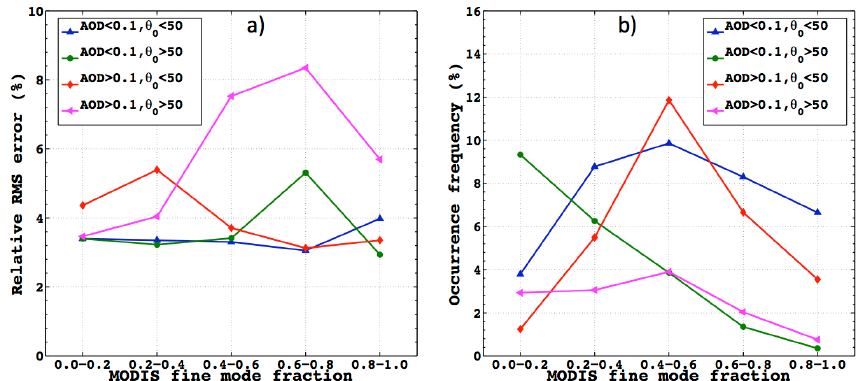
Figure 4. The relative RMSEs between oblique-view and near-nadir-view fluxes as a function of MODIS fine-mode fraction separated by aerosol optical depth ( τ ) of 0.1 and solar zenith angles ( θ 0 ) of 50 ◦ (a) , and the occurrence frequency for each population (b) .